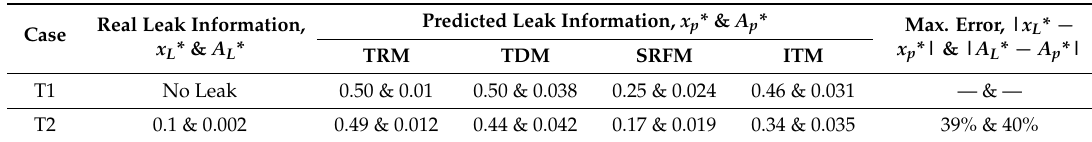
Table 3. Results of leak detection under the presence of wave scattering in the